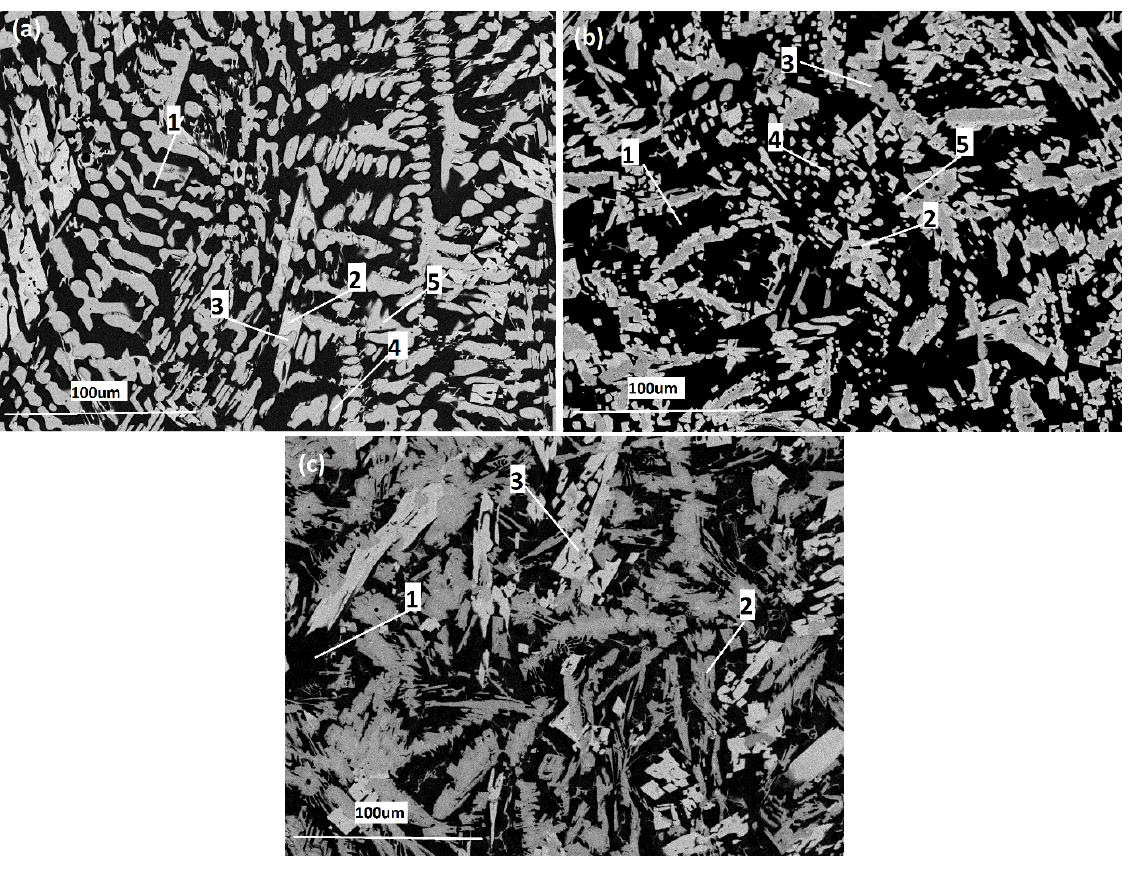
Figure 1: SEM/BSE images of the as-cast alloys from the first series of experiments ( × 500) a) Sample A, b) Sample B, and c) Sample C.